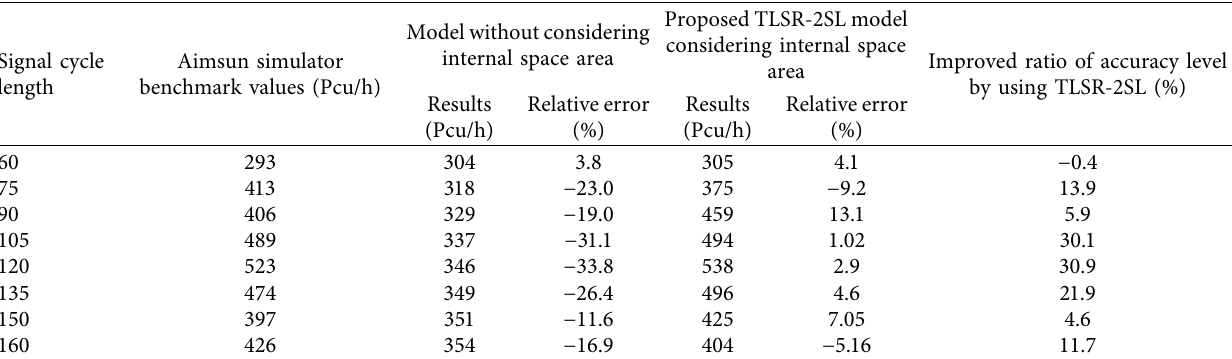
Figure 5: Optimal signal cycle length with respect to inscribed island radius and Aimsun simulator. (a) Aimsun Next simulator. (b) Optimal signal cycles’ Table 2: Left-turn capacity analysis of the proposed model.